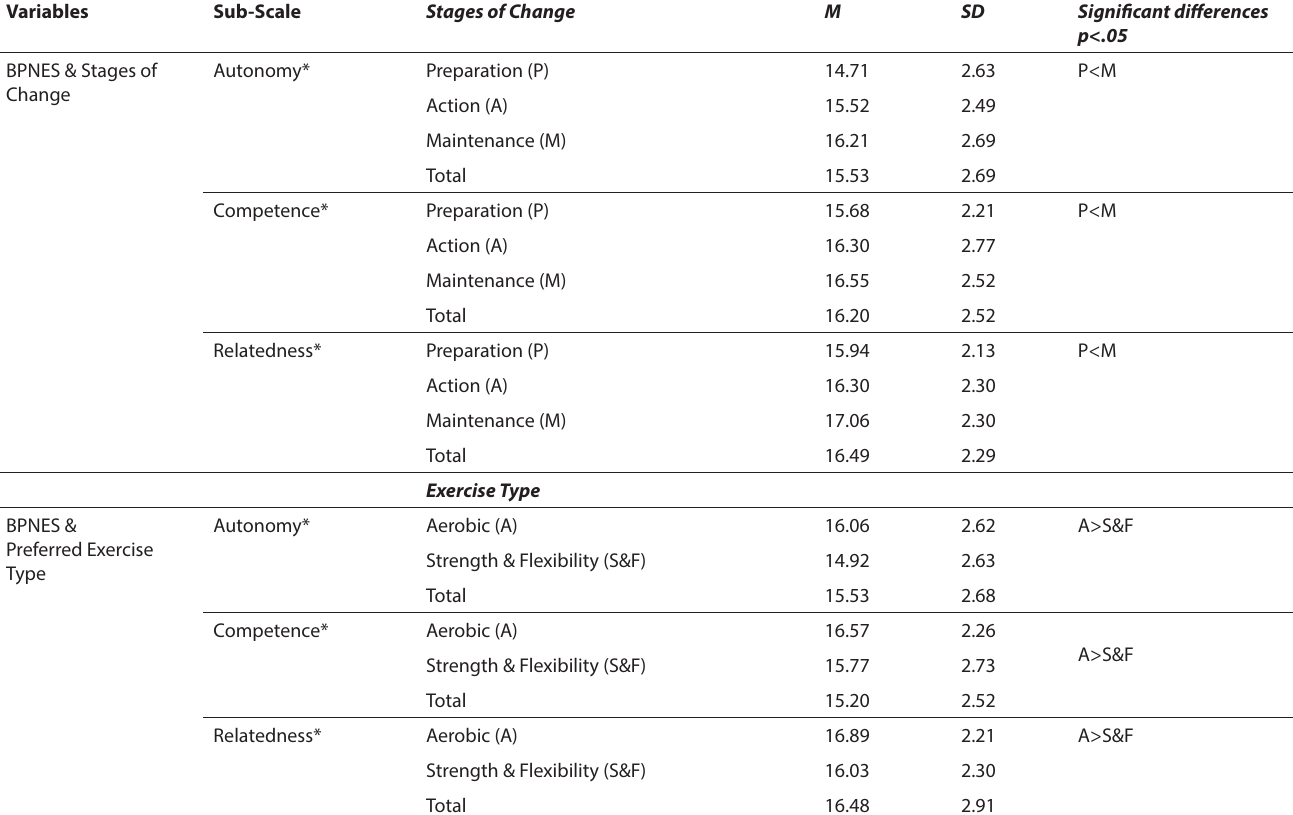
TABLE 2. Descriptive Statistics of the BPNES by Stages of Change and Preferred Type of Exercise. Variables